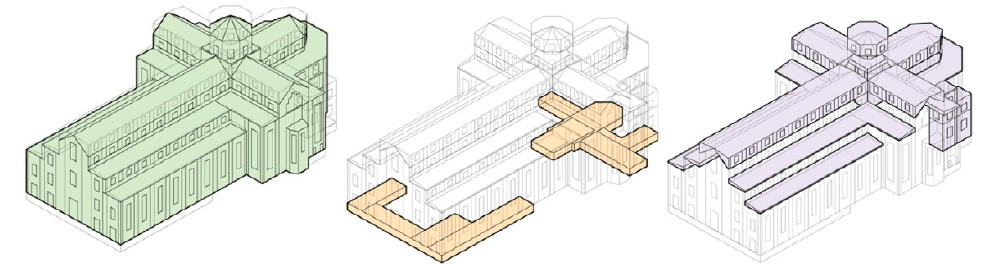
Figure 6. View of the thermal zones of the simulation model.